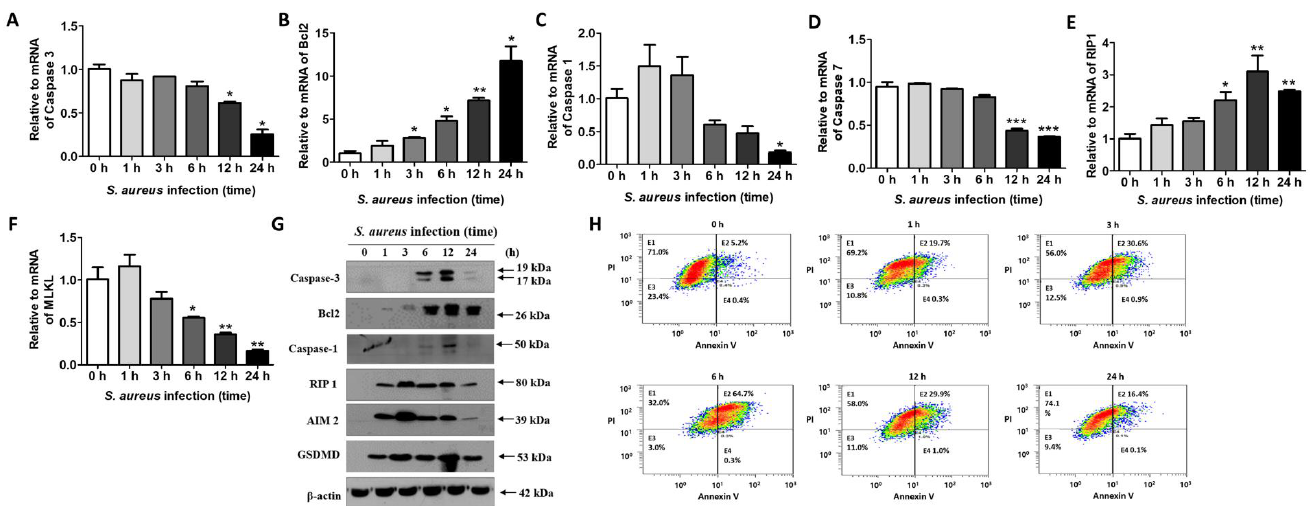
Figure 4. S. aureus -mediated cell death in HaCaT cells. HaCaT cells were treated with 1 × 10 8 CFU/mL of S. aureus for the indicated times. Real-time PCR was performed to examine the mRNA levels of caspase-3 ( A ), Bcl2 ( B ), caspase-1 ( C ), caspase-7 ( D ), Rip1 ( E ), and MLKL ( F ). The data displayed are the mean ± SD of three independent experiments. Statistical analysis was conducted with a one-way ANOVA. * p < 0.05, ** p < 0.01, *** p < 0.001 vs. 0 h. ( G ) Protein levels were examined via Western blotting. ( H ) A fluorescence-activated cell sorting (FACS) analysis was performed to examine the type of cell death that occurred in S. aureus -infected HaCaT cells.